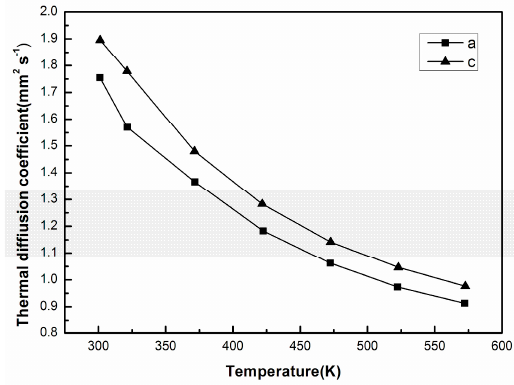
Figure 8. Thermal diffusion coefficient curve along the a -axis and c -axis of the Mg: 7 LiNbO 3 crystal.